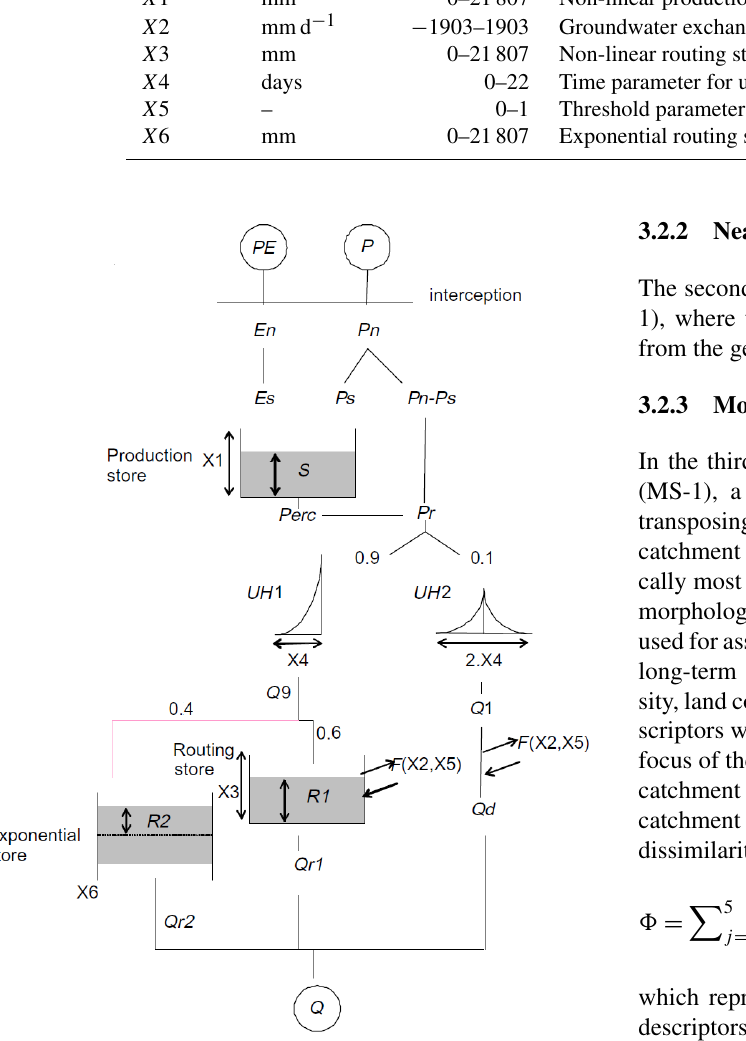
Figure 3. GR6J model scheme (Pushpalatha et al., 2011).